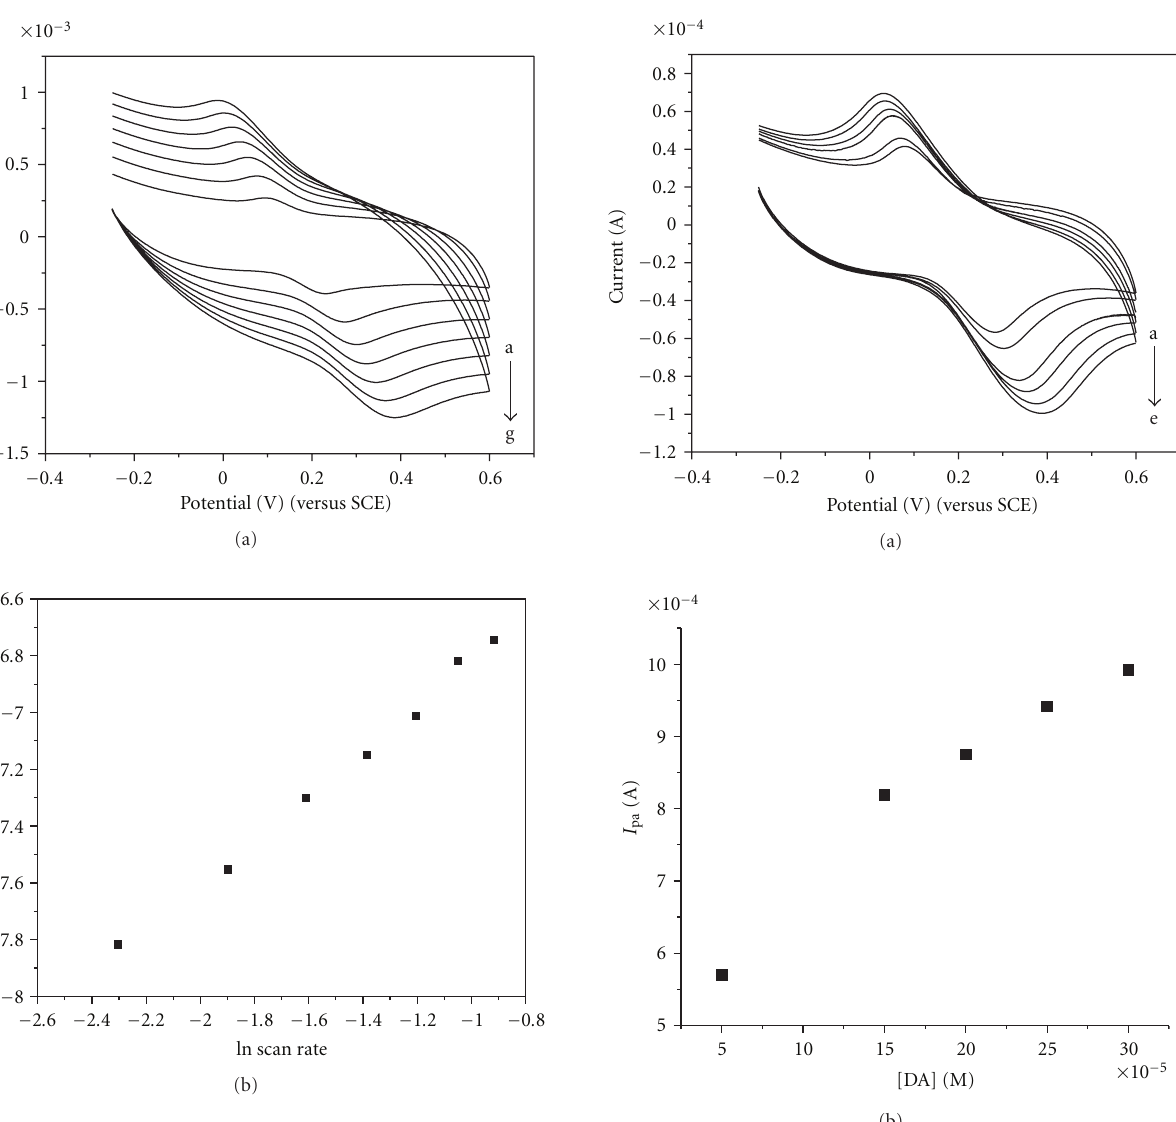
Figure 3: (a) Cyclic voltammogram of 5 × 10 − 5 M DA in 0.2 M phosphate bu ff er solution at di ff erent scan rate (a–g; 0.1 Vs − 1 , 0.15Vs − 1 , 0.2Vs − 1 , 0.25 Vs − 1 , 0.3 Vs − 1 , 0.35 Vs − 1 , and 0.4 Vs − 1 ). (b) Graph of current versus square root of scan rate.